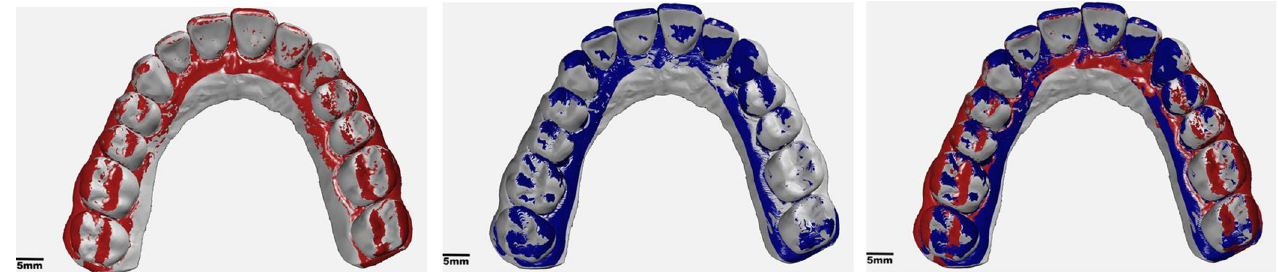
Fig 6. Compensation of the arch expansion during the entire workflow: (a) [REF vs. IOS] (grey = reference cast; red = IOS) The arch of [IOS] is widened in relation to the reference cast; (b) [REF vs. DLP] (grey = ref; blue = printed) [DLP] shows a narrower arch than [REF]; (c) Superimposition of [REF vs. IOS] and [REF vs. DLP] The expansion of the intraoral scan is overcompensated during the printing process.